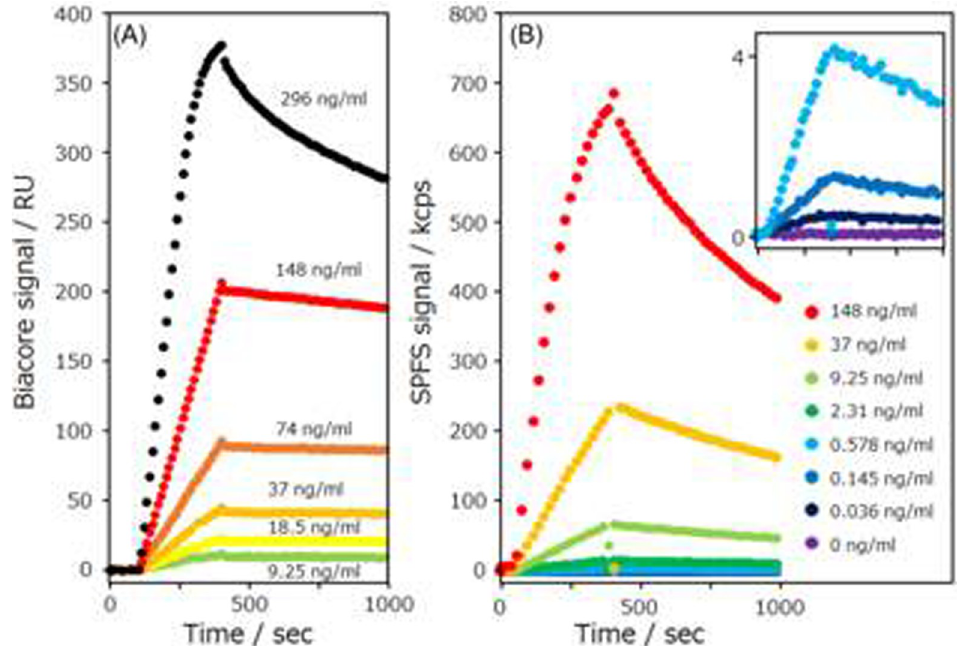
Fig 5. Affinity curves of wild-type anti-lysozyme sdAb. (A) Time course curve of Biacore system and (B) GC-SPFS fluorescence signal for the difference between the p- and s- polarizations with the lysozyme immunoassay by using the Alexa-647-labeled wild-type sdAb.